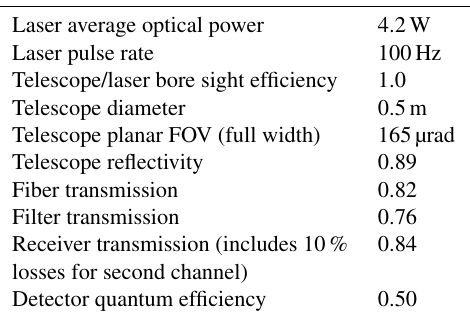
Table 2. Instrument parameters used in the performance simula-